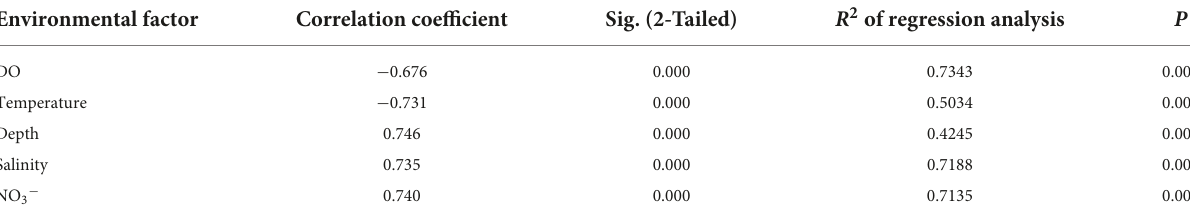
TABLE 1 Spearman’s correlation analysis between Shannon diversity and environmental